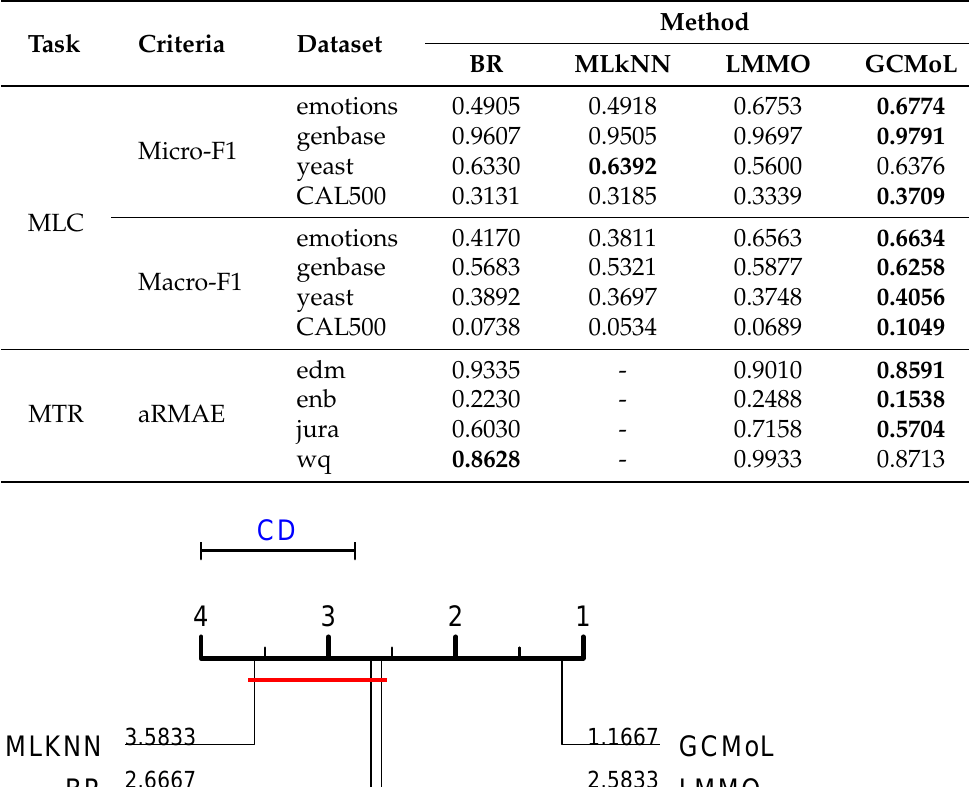
Figure 1. Comparison of GCMoL against other comparing algorithms with the Nemenyi